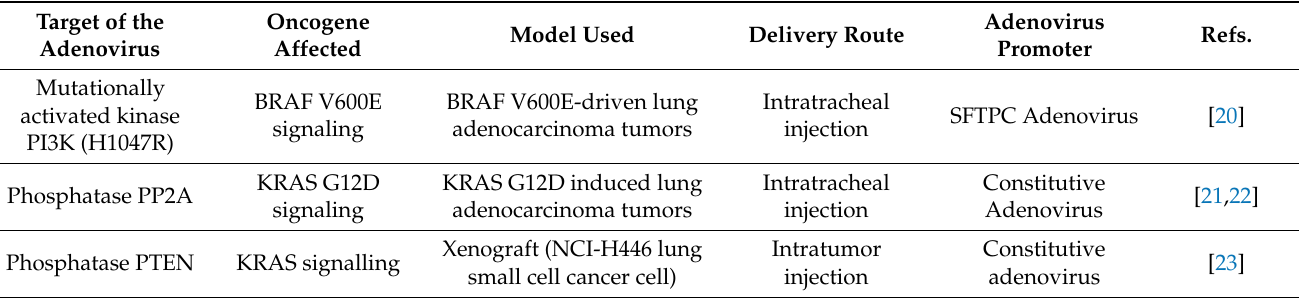
Table 2. Oncogenic phosphatases/kinases that could be targeted using